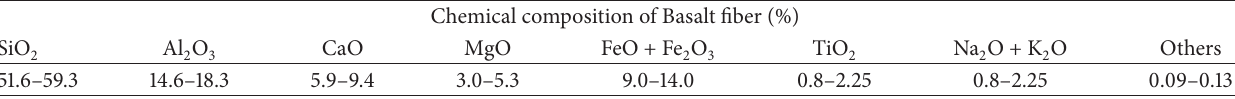
Table 3: Chemical composition of Basalt fibers chopped strands.